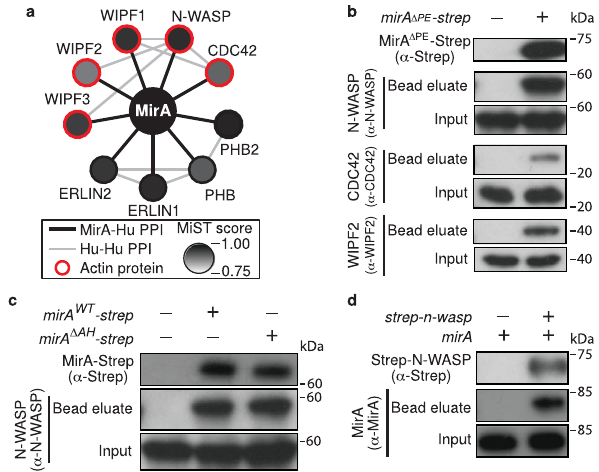
Fig. 6 MirA interacts with N-WASP and N-WASP-interacting proteins involved in actin regulation. a A schematic of the MirA-host interactome determined through an AP-MS approach in HEK293 cells detecting protein- protein interactions (PPI) determined using the MiST algorithm 28 . Black lines indicate MirA-human protein interactions, gray lines indicate human-human interactions (via STRING 72 ), and actin cytoskeletal proteins are circled in red. b Representative immunoblots of MirA-Strep af fi nity-puri fi ed lysates blotted against actin cytoskeletal proteins (N-WASP, CDC42, and WIPF2) identi fi ed as MirA interacting factors. c Representative immunoblots of the MirA-Strep amphipathic helix mutant af fi nity-puri fi ed lysates against N-WASP. d Representative immunoblots of the Strep-N-WASP af fi nity-puri fi ed lysates against MirA. Data shown in b – d are representative of three independent experiments. Source data are provided as a Source data fi